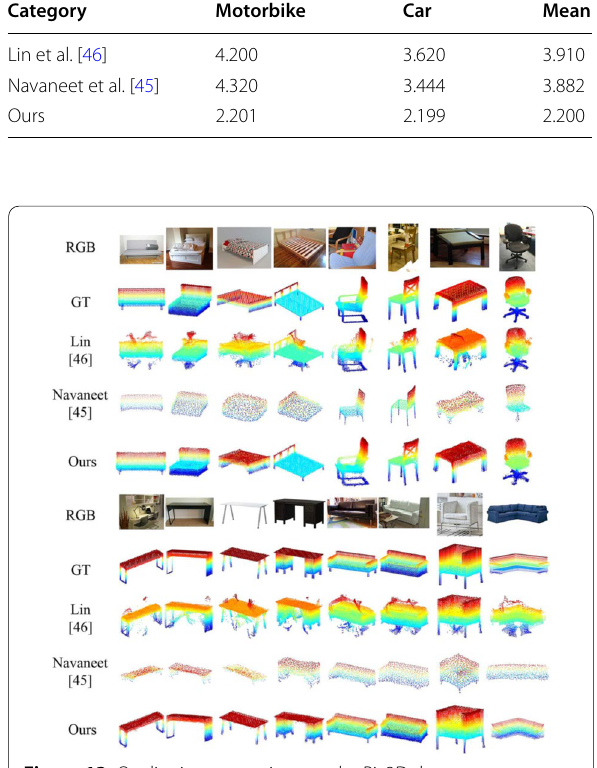
Figure 13 Qualitative comparison on the Pix3D dataset